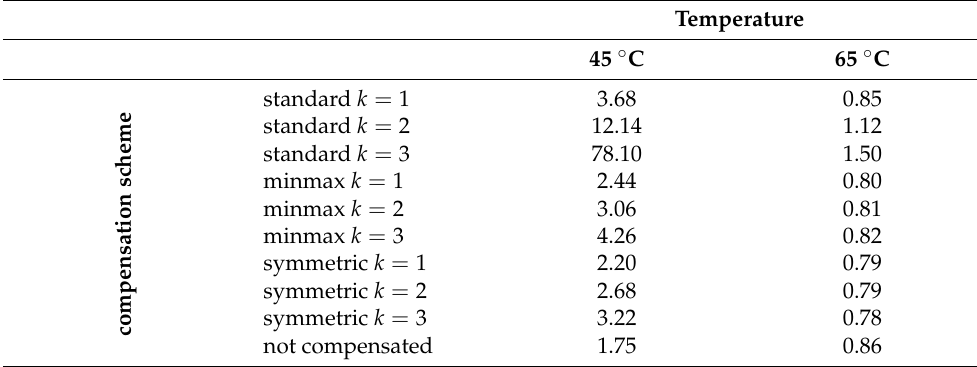
Table 4. D ef f coefficient for divAmp damage index obtained for specimen no. 2 (temperature measured at the reference point of the